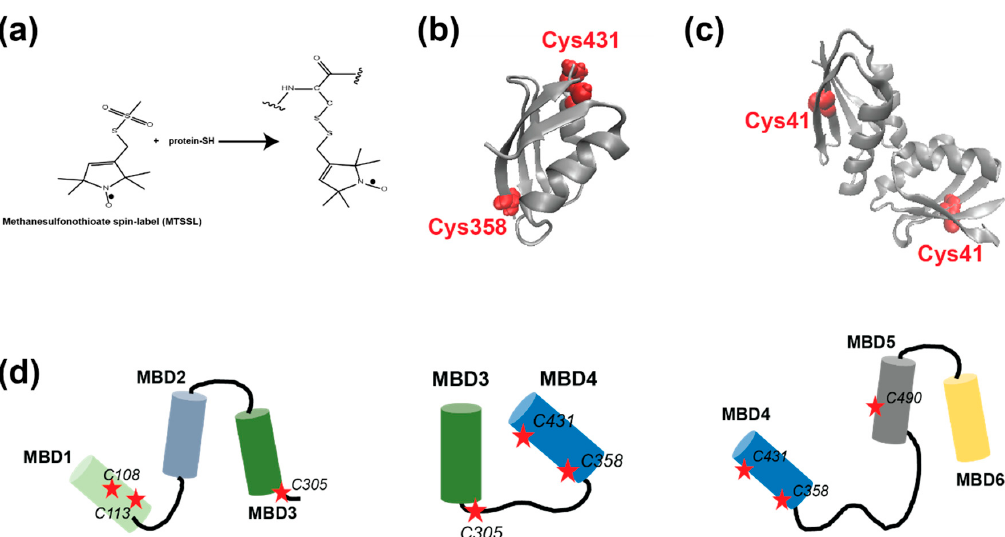
Figure 1. ( a ) The scheme of the site-directed spin-labeling of the methanesulfonothioate (MTSL) nitroxide radical to cysteine residues. ( b ) The MBD4 structure, PDB 2ROP; the cysteine residues accessible for spin-labeling are denoted in red. ( c ) The Atox1 dimer structure, PDB 3IWX; the cysteine residues accessible for spin-labeling are denoted in red. ( d ) Cartoons of the MBDs of ATP7B studied here. The red stars denote the cysteine residues, which were spin labeled.